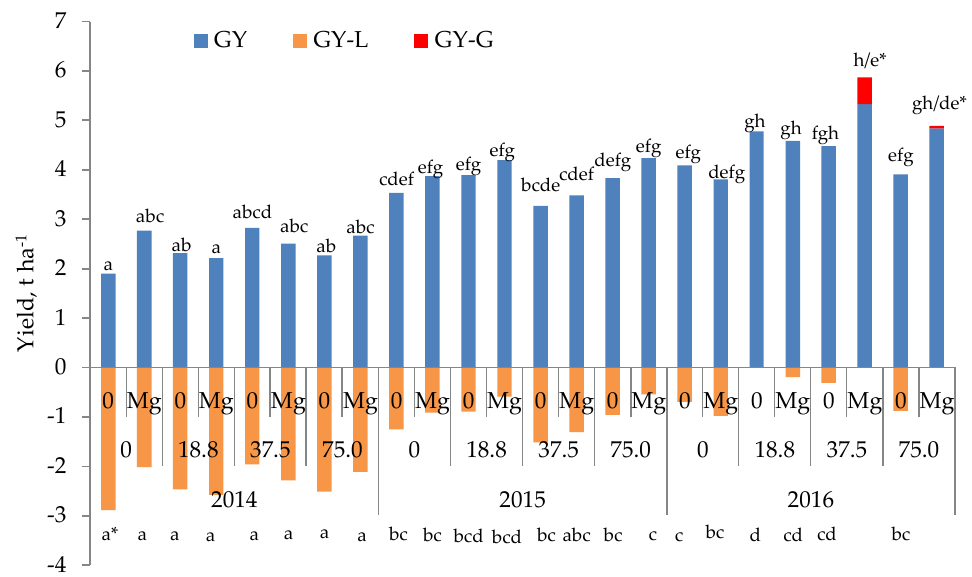
Figure 2. Effect of fertilization treatments on the grain yield (GY), yield-gap (GY-L) and net grain yield gain (GY-G) of spelt wheat depending on the year. Potassium rates: 0 kg K ha −1 , 18.8 kg K ha −1 , 37.5 kg K ha −1 , 75.0 kg K ha − 1 ; 0 kg Mg ha −1 — control, without Mg fertilization; Mg — magnesium fertilization (10.5 kg Mg ha − 1 ). The same letter indicates a lack of significant differences within the treatment; * — test for the GY-L.